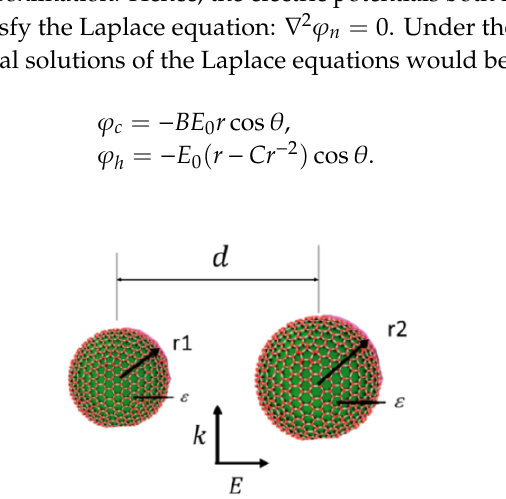
Figure 1. Schematic diagram of the graphene-wrapped dielectric dimer in vacuum illuminated by the linear polarized light whose E direction is along the dimer axis. The radii of two particles are r 1 and r 2 , respectively, and the center-to-center distance is d